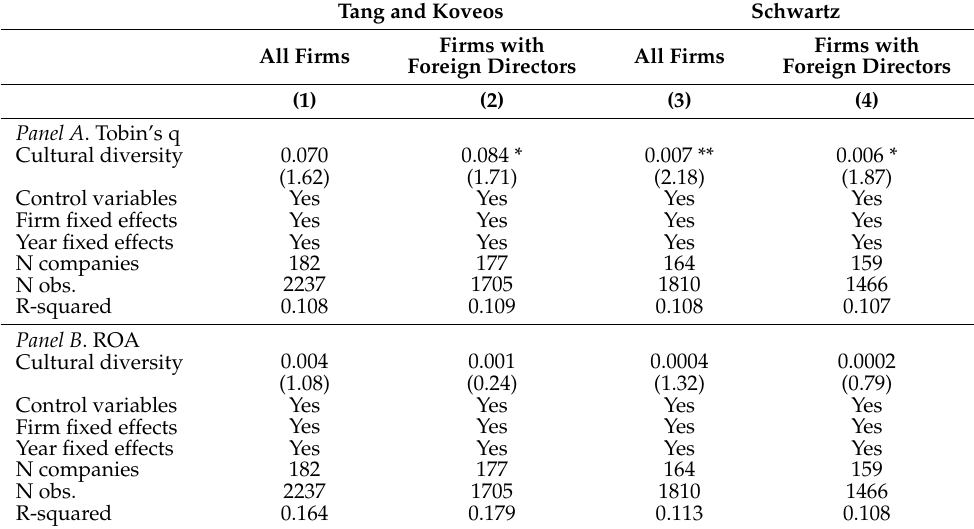
Table 7. Alternative measures of board cultural